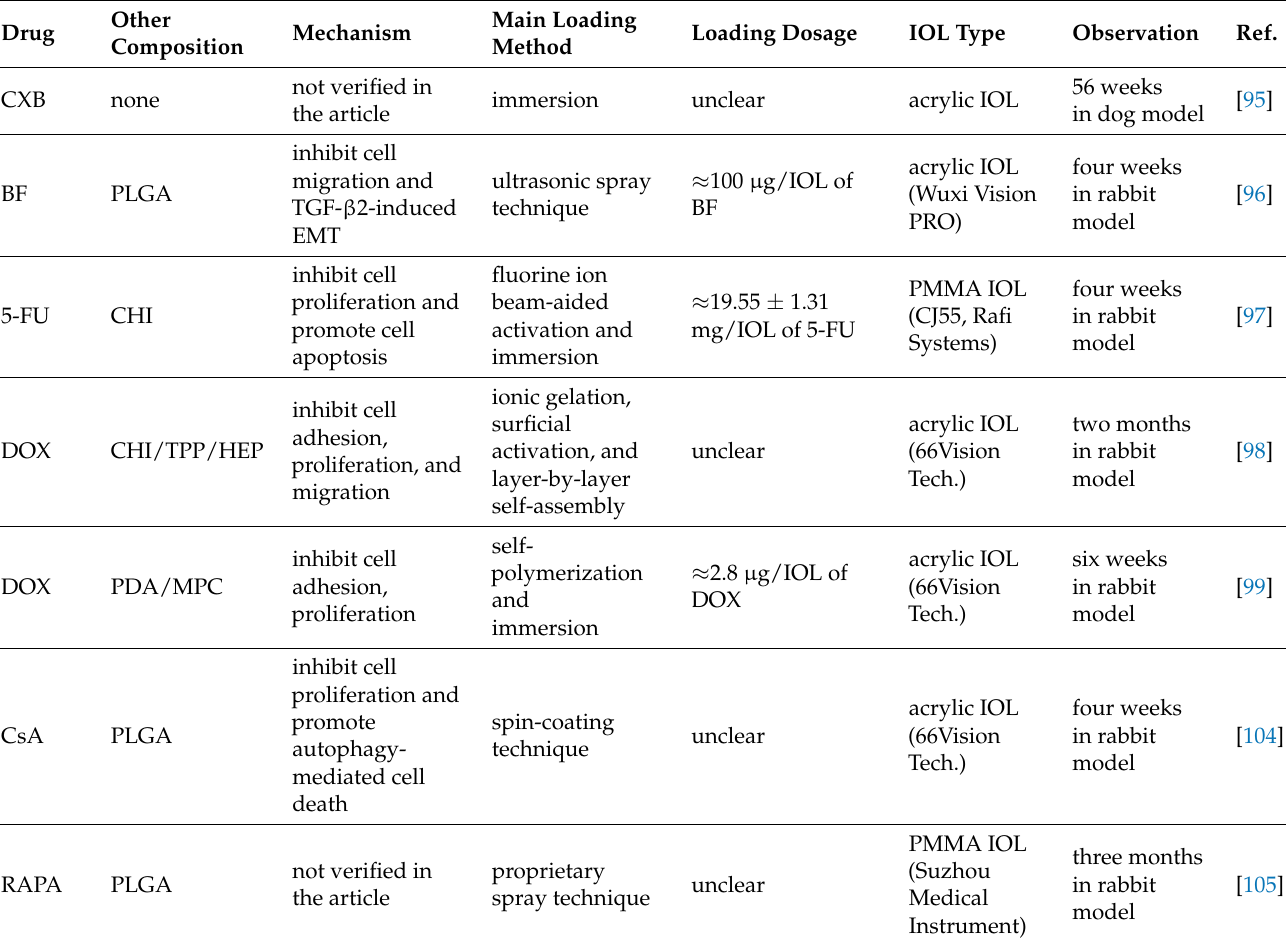
Table 3. Summary of reviewed literature of drug-loaded IOLs for PCO prophylaxis with in vivo